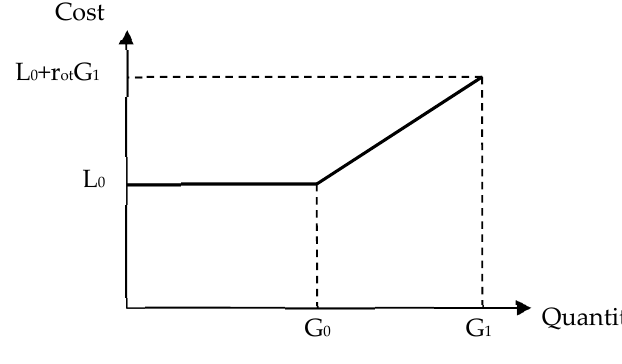
Figure 2. Direct labor cost function.